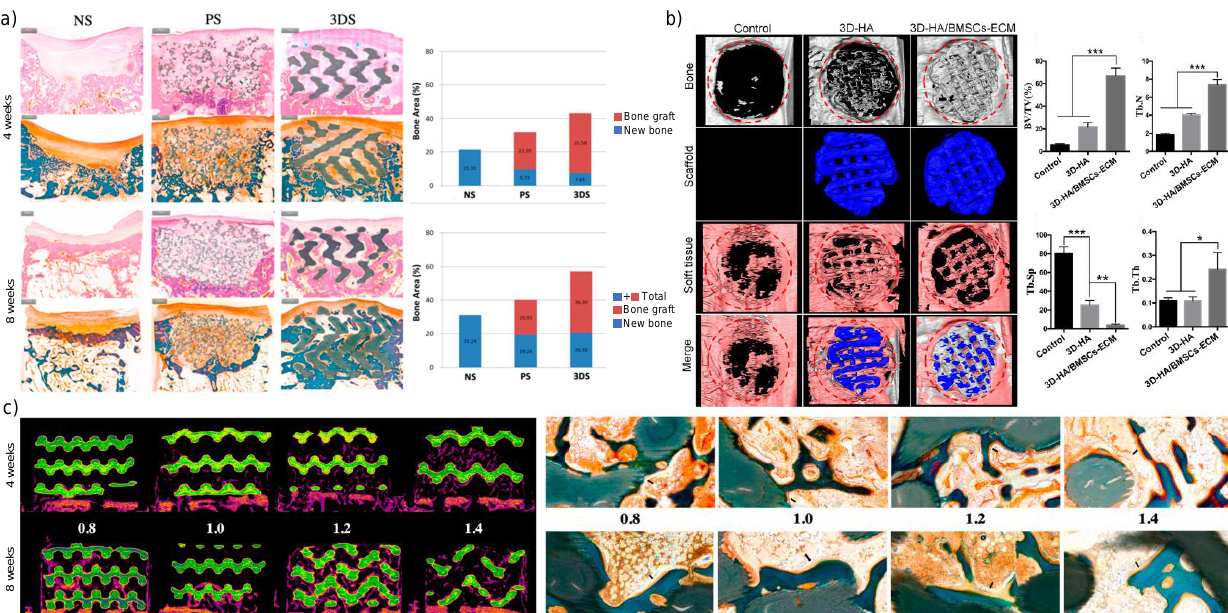
Figure 3. The properties affecting bone regeneration of nHA-based 3D printing scaffolds. ( a ) Histomorphometric examina- tion demonstrated that the 3D printed HA/ tricalcium phosphate scaffold (3DS) had better bone reparation effect than both negative control (NS) and positive control (particle-type bone substitutes, PS) in beagle dog mandibular bone defects [30]. ( b ) Radiographic analysis showed that 3D hydroxyapatite/extracellular matrix (HA/ECM) composites promoted bone regeneration in rat calvarial defects after 12 weeks [34]. ( c ) Both radiographic and histological evaluations exhibited more new bone formation for 3D printed nHA-based scaffolds with higher pore size only at 4 weeks [35]. *: p < 0.05, **: p < 0.01, ***: p <